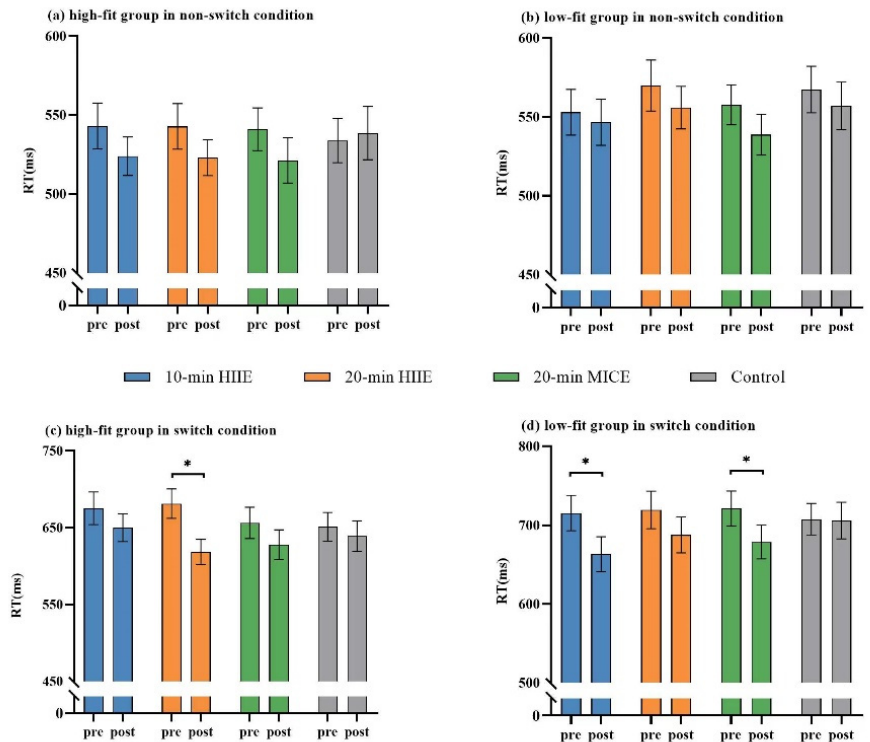
Figure 2. RTs under the non-switching condition in high-fitness group ( a ) and low-fitness group ( b ), and RTs under the switching condition in the high-fitness group ( c ) and the low-fitness group ( d ). Error bars represent the standard error for the mean (* p < 0.00625 for Bonferroni correction).